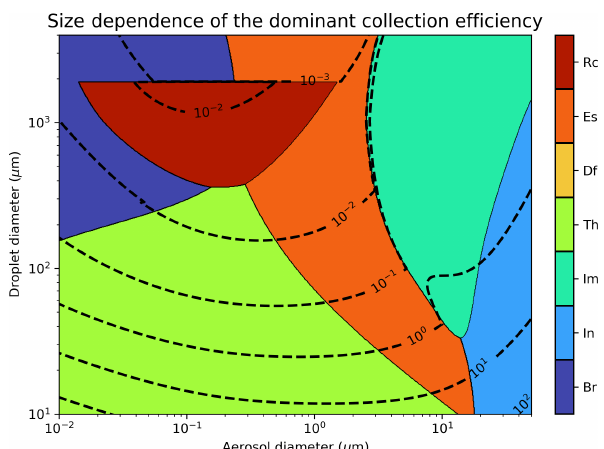
Figure 2. The dominant contributor to the total collection efficiency (i.e. the largest determined numerically) as a function of aerosol di- ameter and raindrop diameter, where Rc is rear capture, Es is elec- tric charge, Df is diffusiophoresis, Th is thermophoresis, Im is in- ertial impaction, In is interception, and Br is Brownian diffusion. Dashed lines show logarithmically spaced contours of total collec- tion